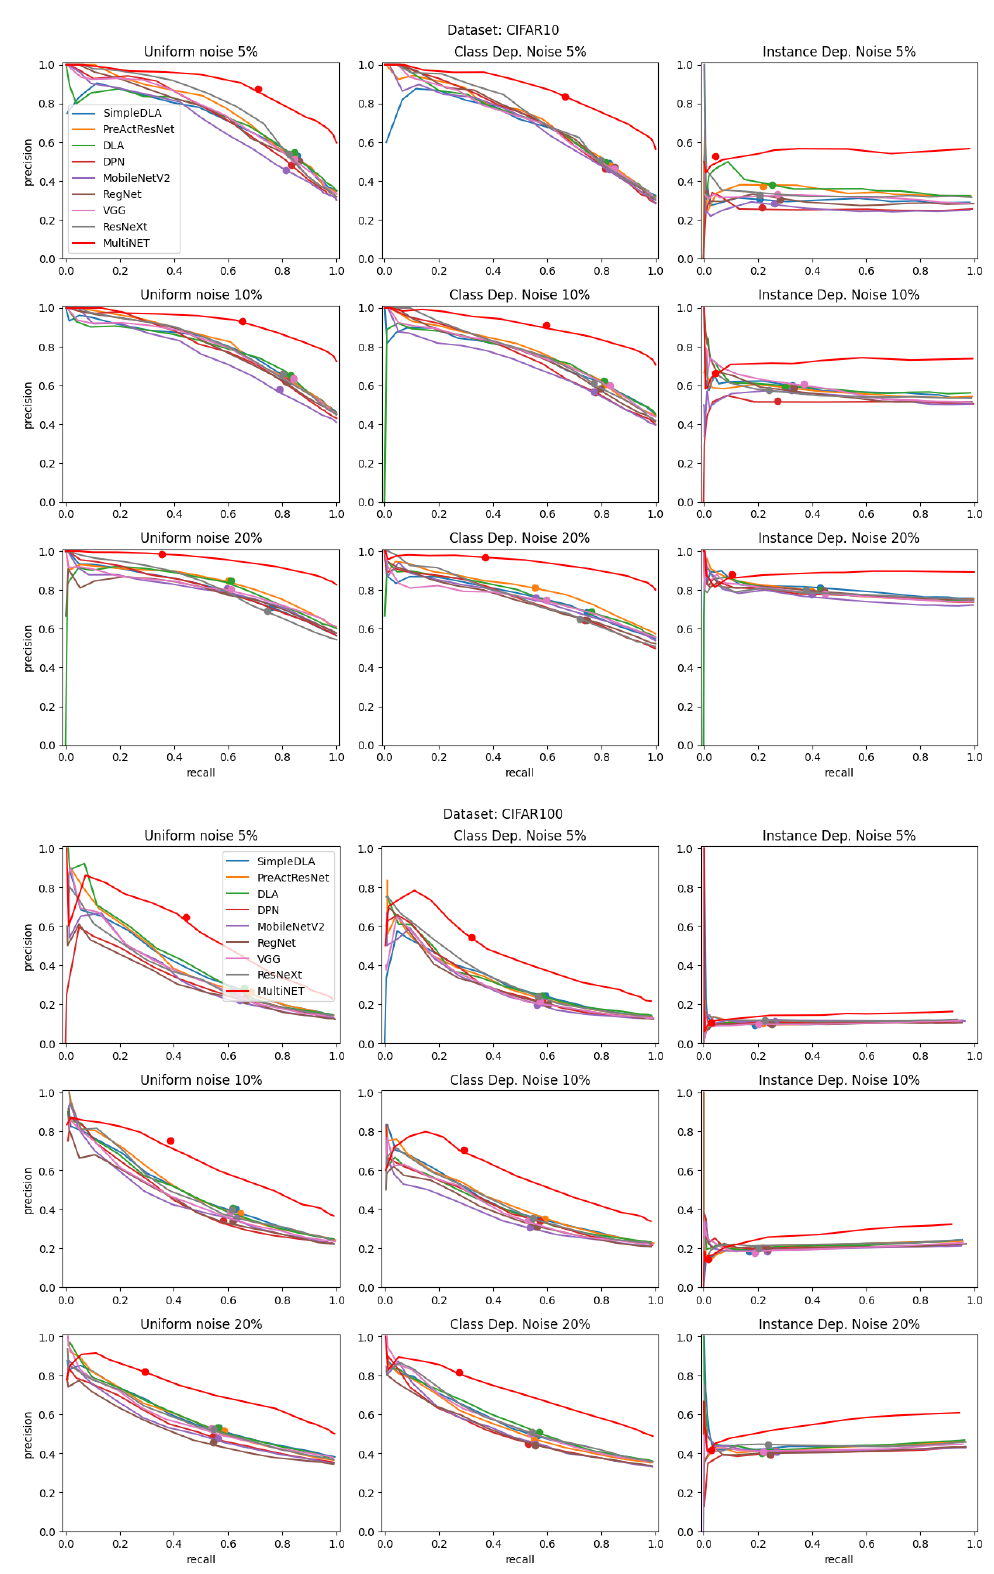
Figure 7. Precision–recall curves for the CIFAR10 and CIFAR100 datasets. The red line denotes the results of the MultiNET algorithm, while the other curves show the outcomes of single-DNN CL methods. The original concept utilizing the mean confidence level is denoted by a dot on each